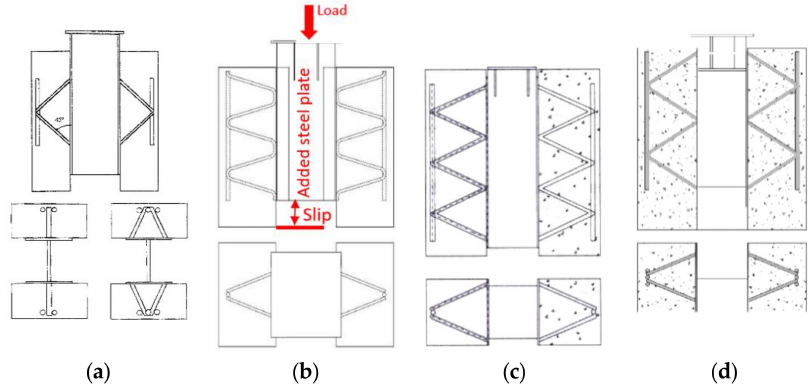
Figure 4. Geometry of specimens: ( a ) Puhali and Smotlack (1980) [4]; ( b ) Tullini and Minghini [7]; ( c ) Aiello [5]; ( d ) Badalamenti et al. [14]. Table 1. Specimen features and experimental results by Puhali and Smotlack